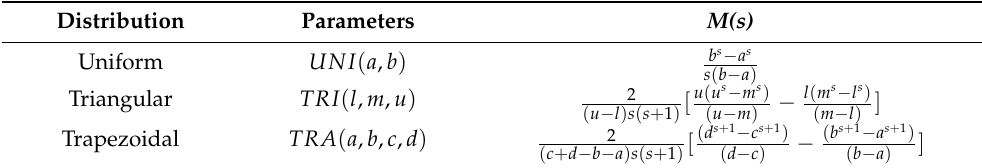
Table 2. Mellin transform of some probability density